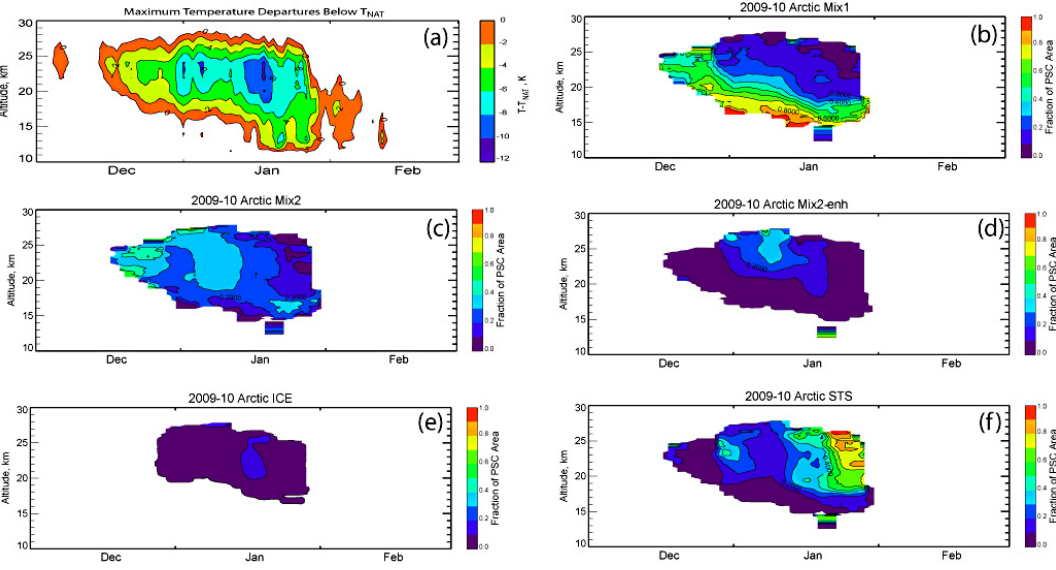
Fig. 17. Relative proportion of PSCs observed in the (b) Mix 1, (c) Mix 2, (d) Mix 2-enh, (e) ice, and (f) STS composition classes as a function of altitude and time. For reference, the maximum temperature departure from T NAT derived from GEOS-5 analyses is shown in panel (a)